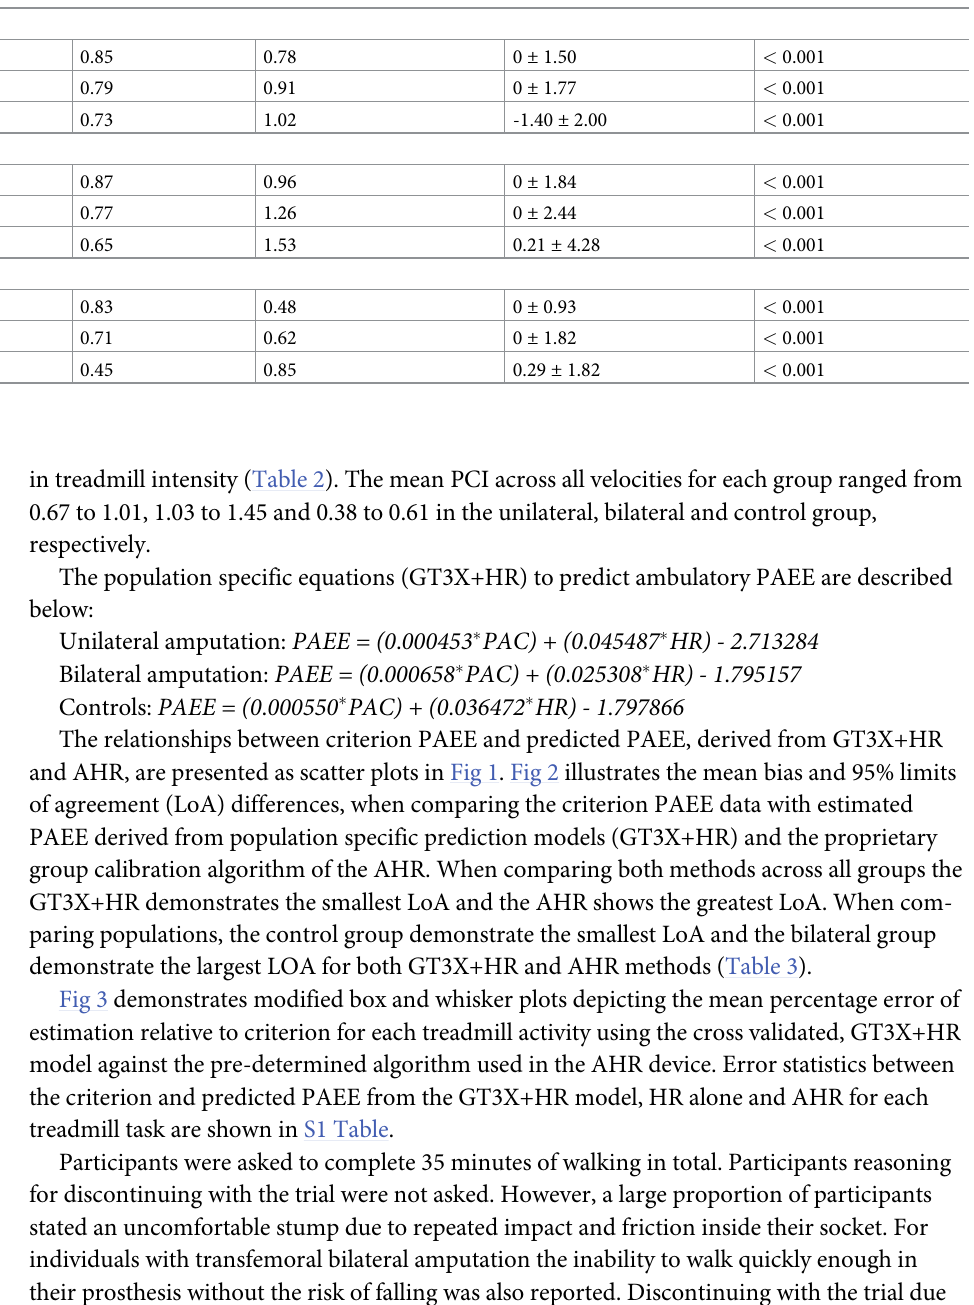
Table 3. The relationships between the three devices of the Actigraph GT3X+ with HR, HR alone Actiheart against criterion PAEE in all groups. Limits of agree- ment (LoA) expressed as mean ± 95% SD. Location